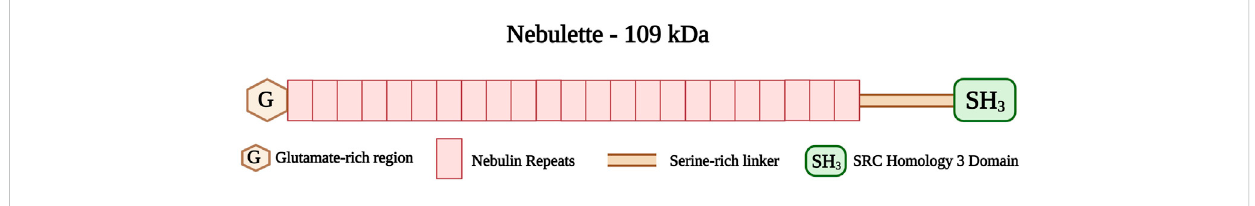
FIGURE 8 Schematic representation of the nebulette with glutamate-rich region (G) at the amino-terminus followed by 23 Nebulin repeats (35 amino acid residues each) and serine-rich linker connecting the SRC Homology 3 (SH3) domain at the carboxy-terminus. Created with BioRender.com.